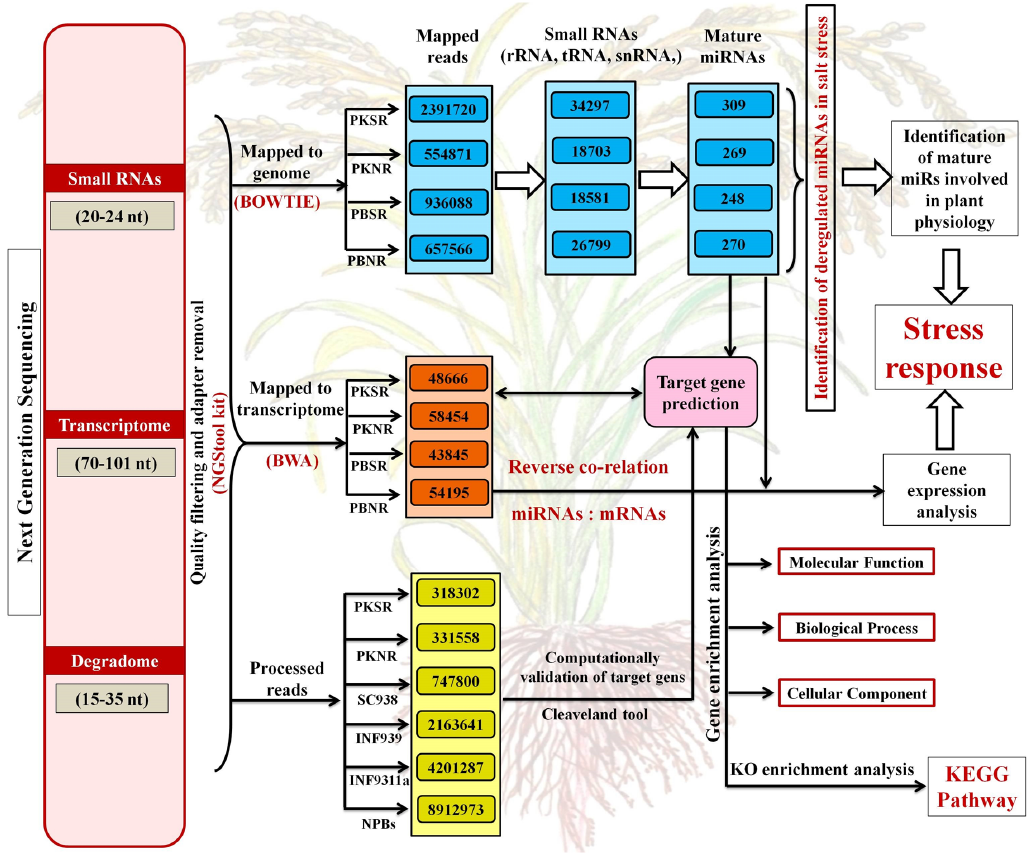
Figure 1. Overview of the analysis of sequencing data for identifying the microRNAs (miRs), mRNAs (transcripts), and cleaved target transcripts from the small RNA, transcriptome, and degradome libraries, respectively. Each panel provides information on the total number of mapped reads. The number of miRs predicted from each library is also indicated. The different arrows indicate the flow chart for performing the analysis. The samples include root tissues from Pokkali grown in the presence of salt (PKSR), Pokkali grown in the absence of salt (PKNR), Pusa Basmati grown in the presence of salt (PBSR), and Pusa Basmati grown in the absence of salt (PBNR). SC938, INF939, INF311a, and NPBs were degradome libraries obtained from open sources to validate the miR targets.